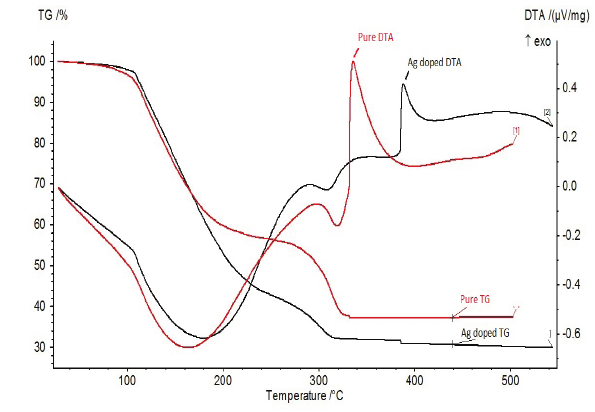
and 5 % Ag Doped TiO 2